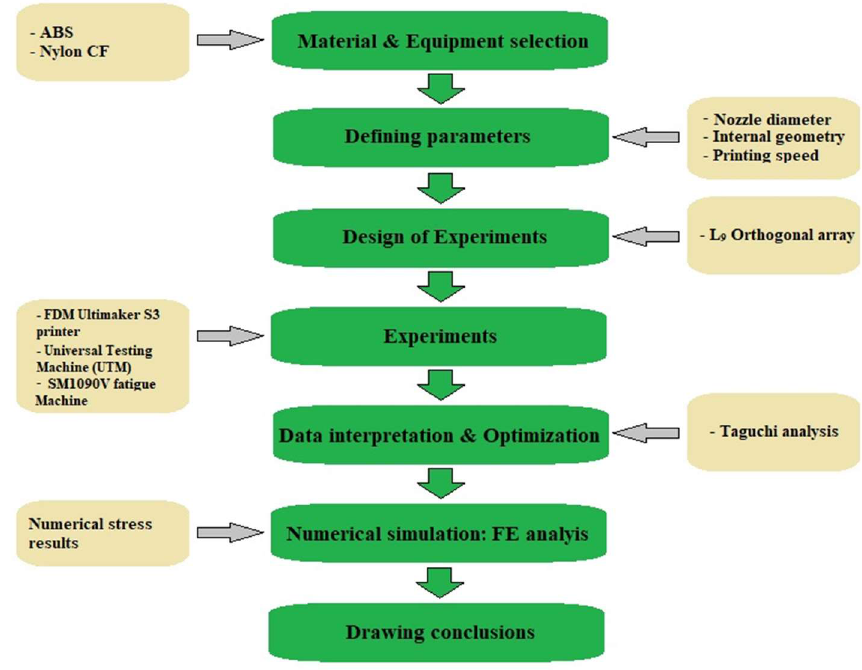
Figure 4. Methodology steps.